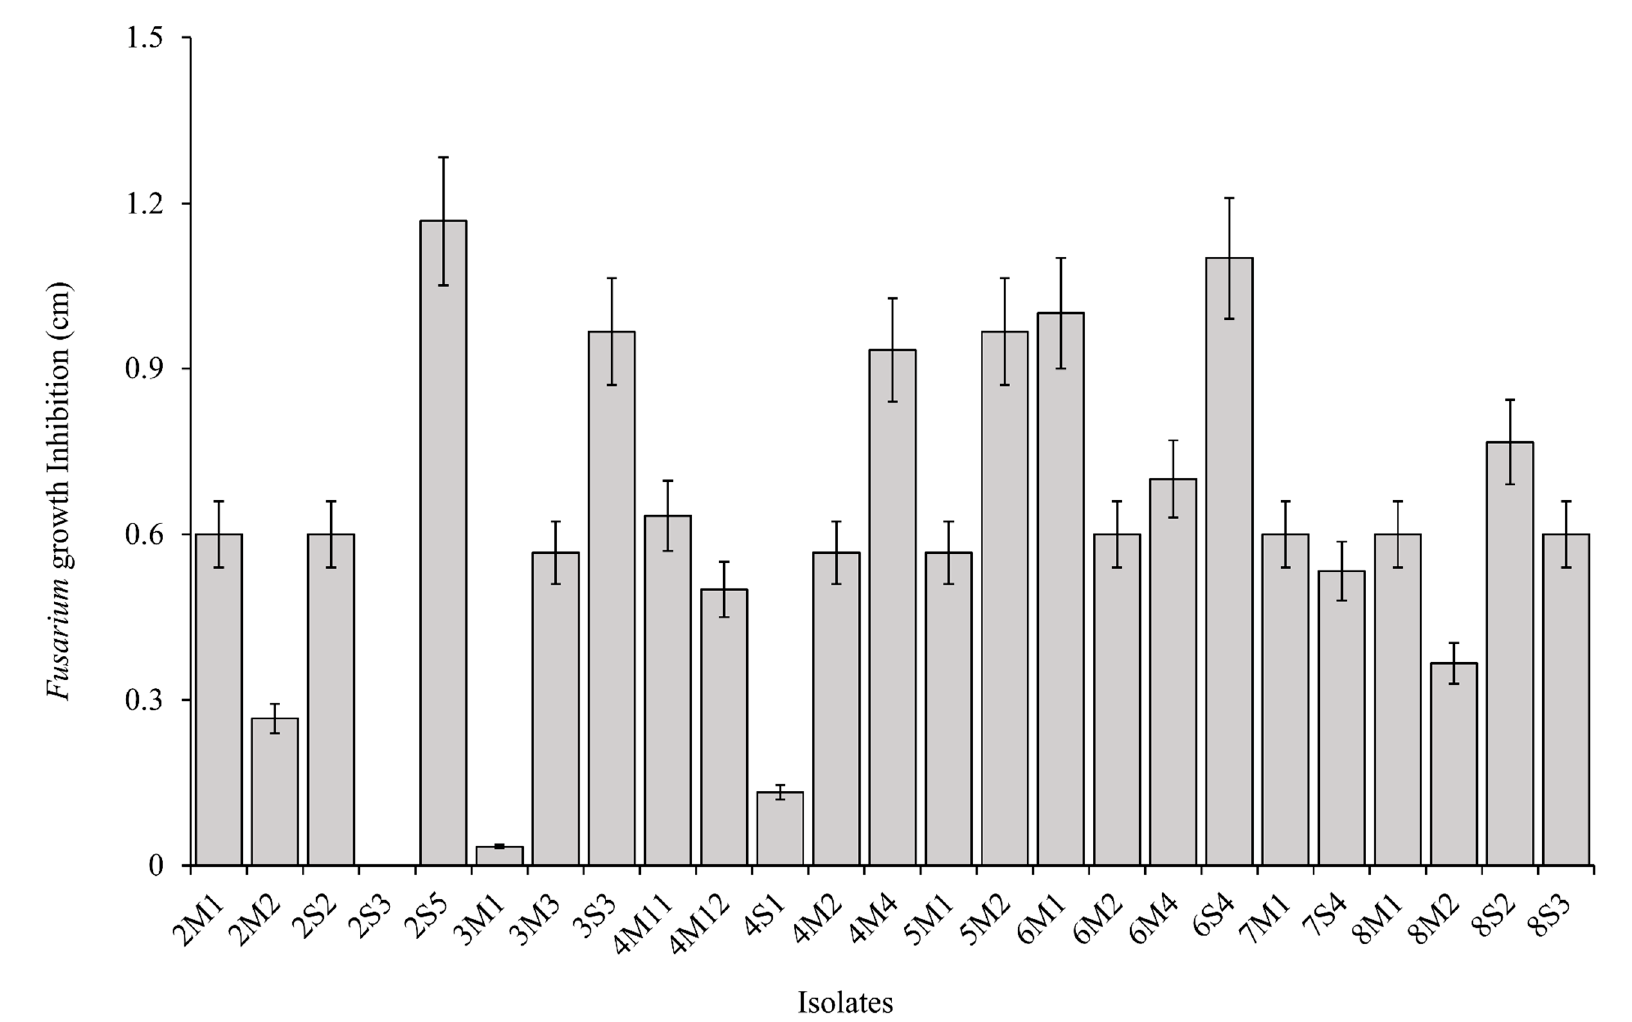
Figure 2. The inhibition area of F. graminearum by LAB isolates to measure antifungal activity. Error bar indicated standard error.